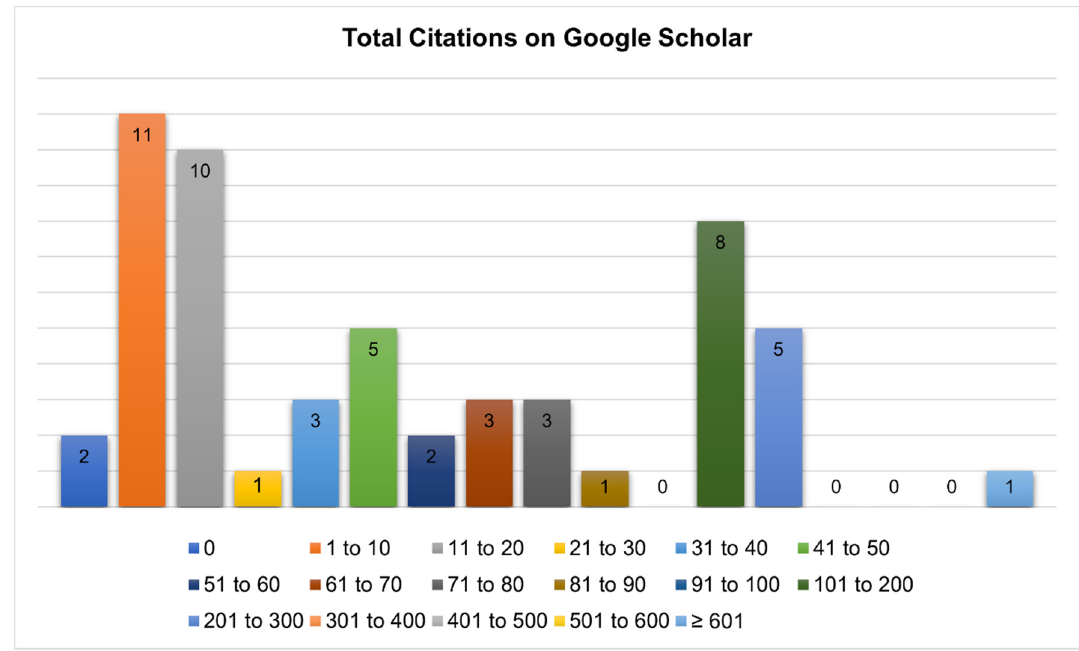
Figure 7. Quantity of papers versus number of citations on Google Scholar.